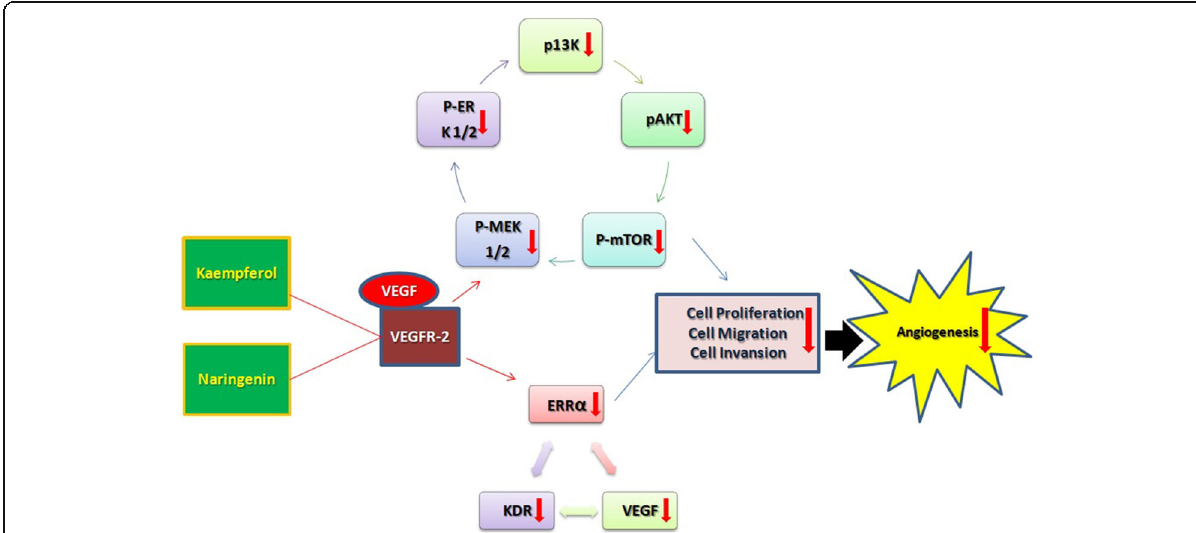
Fig. 2 A representation describing the molecular mechanism of kaempferol and naringenin on the antiangiogenic activity in HUVEC